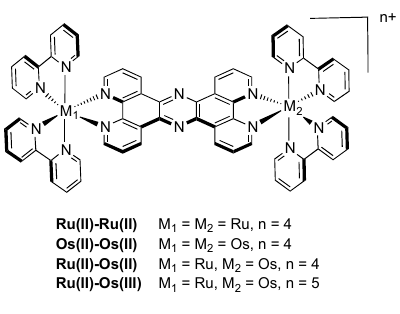
Figure 26. Binuclear TPPHZ